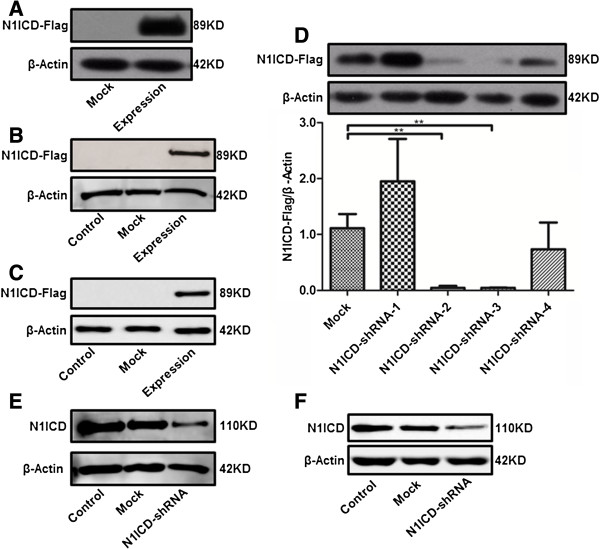
Identification of LV-N1ICD and LV-N1ICD-shRNA vectors. A, Western blots showing the expression of Flag tagged N1ICD in 293T cells as indicated. B, Western blots showing the expression of Flag tagged N1ICD in H9c2 cells as indicated. C, Western blots showing the expression of Flag tagged N1ICD in the hearts of the rats as indicated, D, Western blots showing the expression of Flag tagged N1ICD in 293T cells transfected with pGC-FU-N1ICD-3Flag along with negative control pGVC112-shRNA (Mock), pGVC112-N1ICD-shRNA-1 (N1ICD-shRNA-1), pGVC112-N1ICD-shRNA-2 (N1ICD-shRNA-2), pGVC112-N1ICD-shRNA-3 (N1ICD-shRNA-3), or pGVC112-N1ICD-shRNA-4 (N1ICD-shRNA-4). E, Western blots showing the expression of endogenous N1ICD in H9c2 cells infected by lentivirus as indicated, F, Western blots showing the expression of endogenous N1ICD in the hearts of the rats infected by lentivirus as indicated. β-actin was loading control.